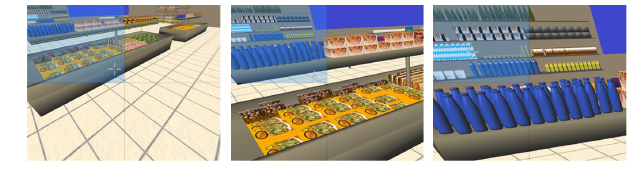
Figure 3. Discrete Zoom Technique